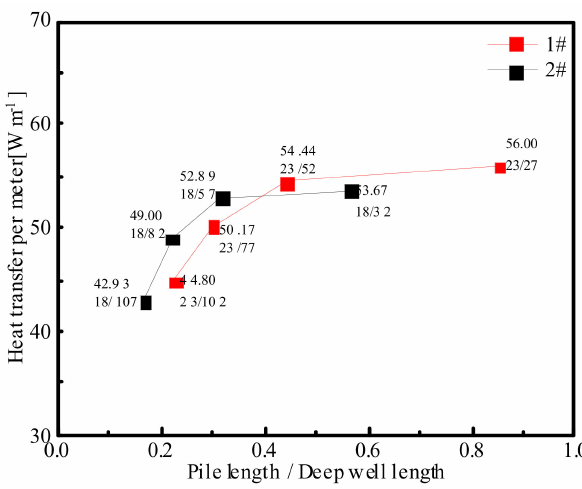
Figure 9. Unit heat exchange distribution of energy piles with different pile-to-well